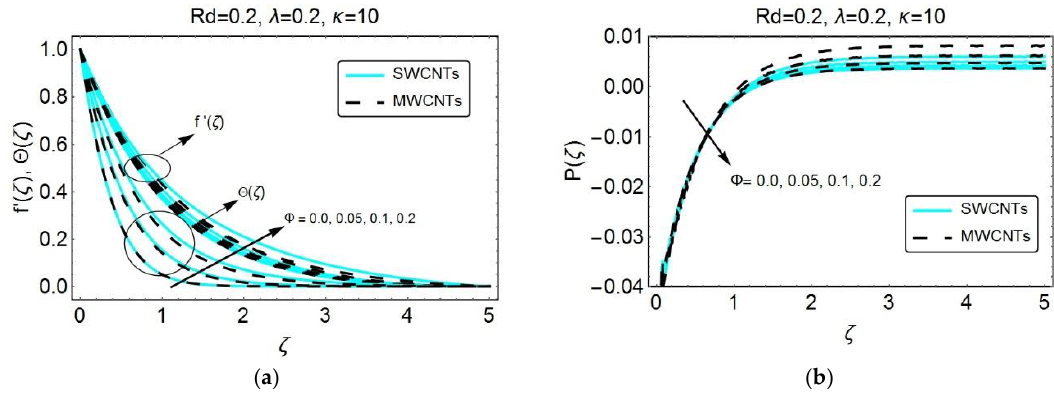
Figure 3. ( a ) 𝑓 ′ ( 𝜁 ) and Θ ( 𝜁 ) ; and ( b ) 𝑃 ( 𝜁 ) for some values of Φ . Figure 3. ( a ) f (cid:48) ( ζ ) and Θ ( ζ ) ; and ( b ) P ( ζ ) for some values of Φ .